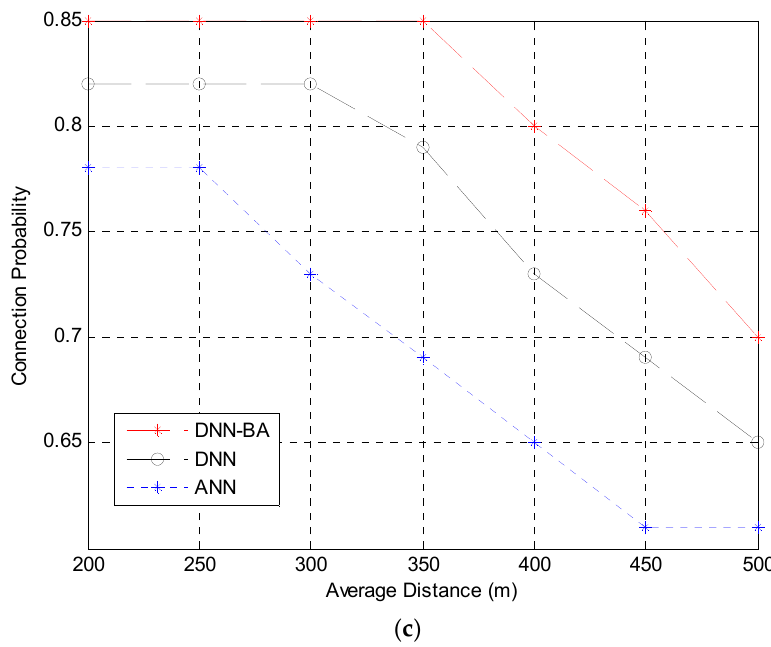
Figure 4. Network Connectivity vs. network density. ( a ) 30 kph; ( b ) 40 kph; ( c ) 50 kph.